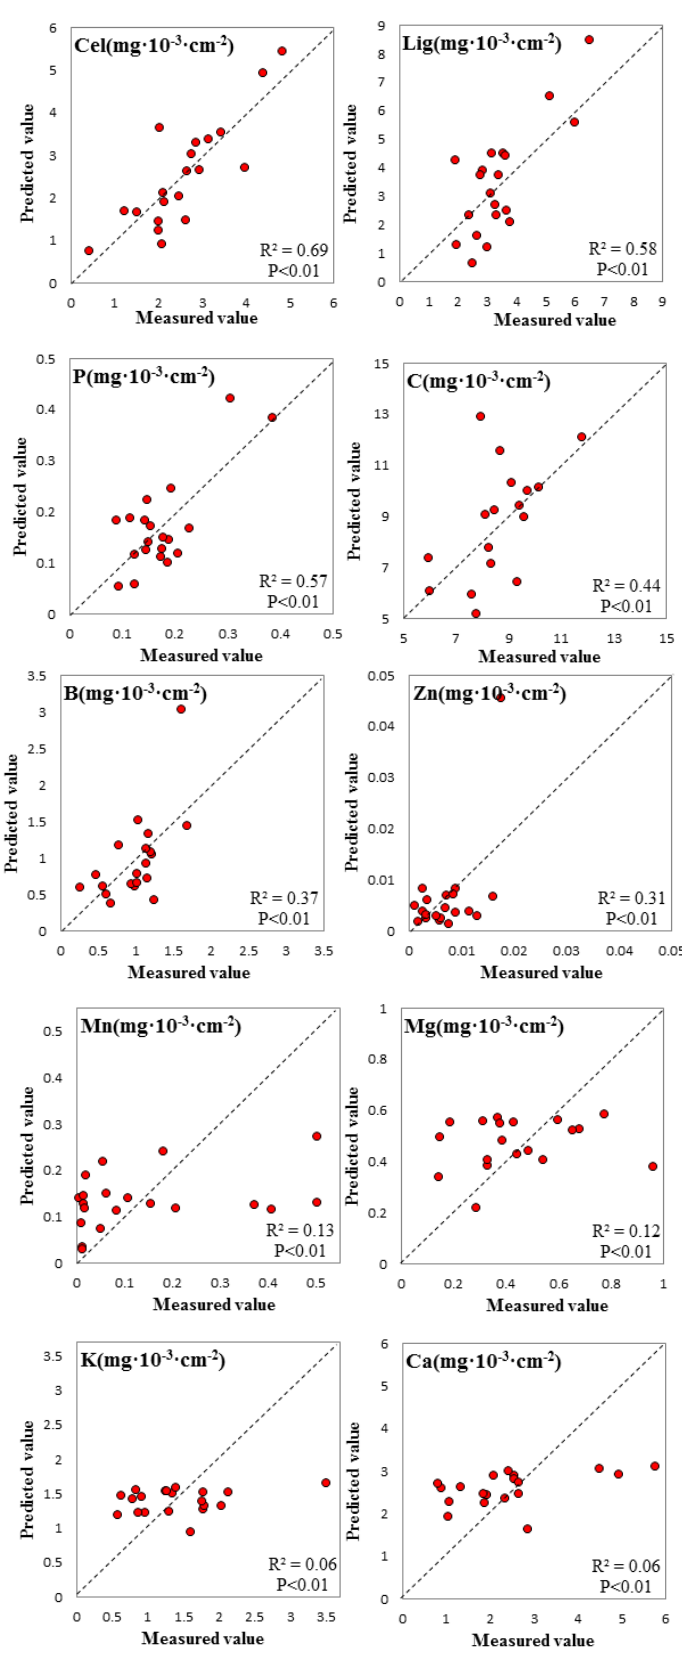
Figure 5. PLS scatterplots show the relationship between the field-measured biochemical components and those predicted by the field spectral